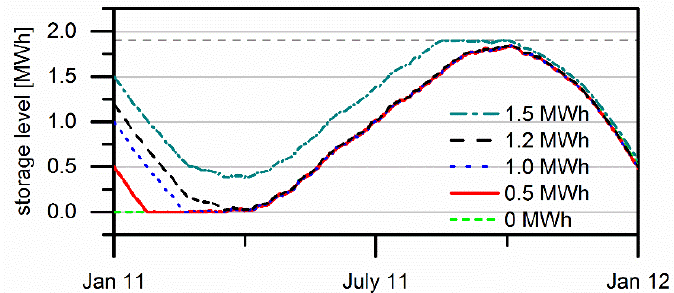
Figure 16. Storage level with different initial